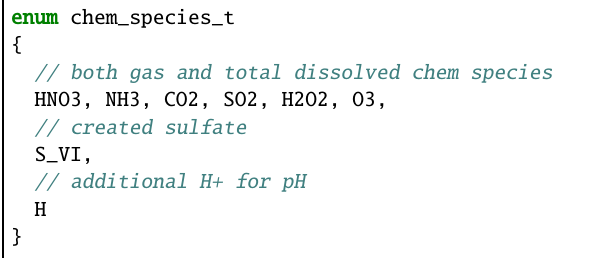
Figure A3. lgrngn::chem_species_t